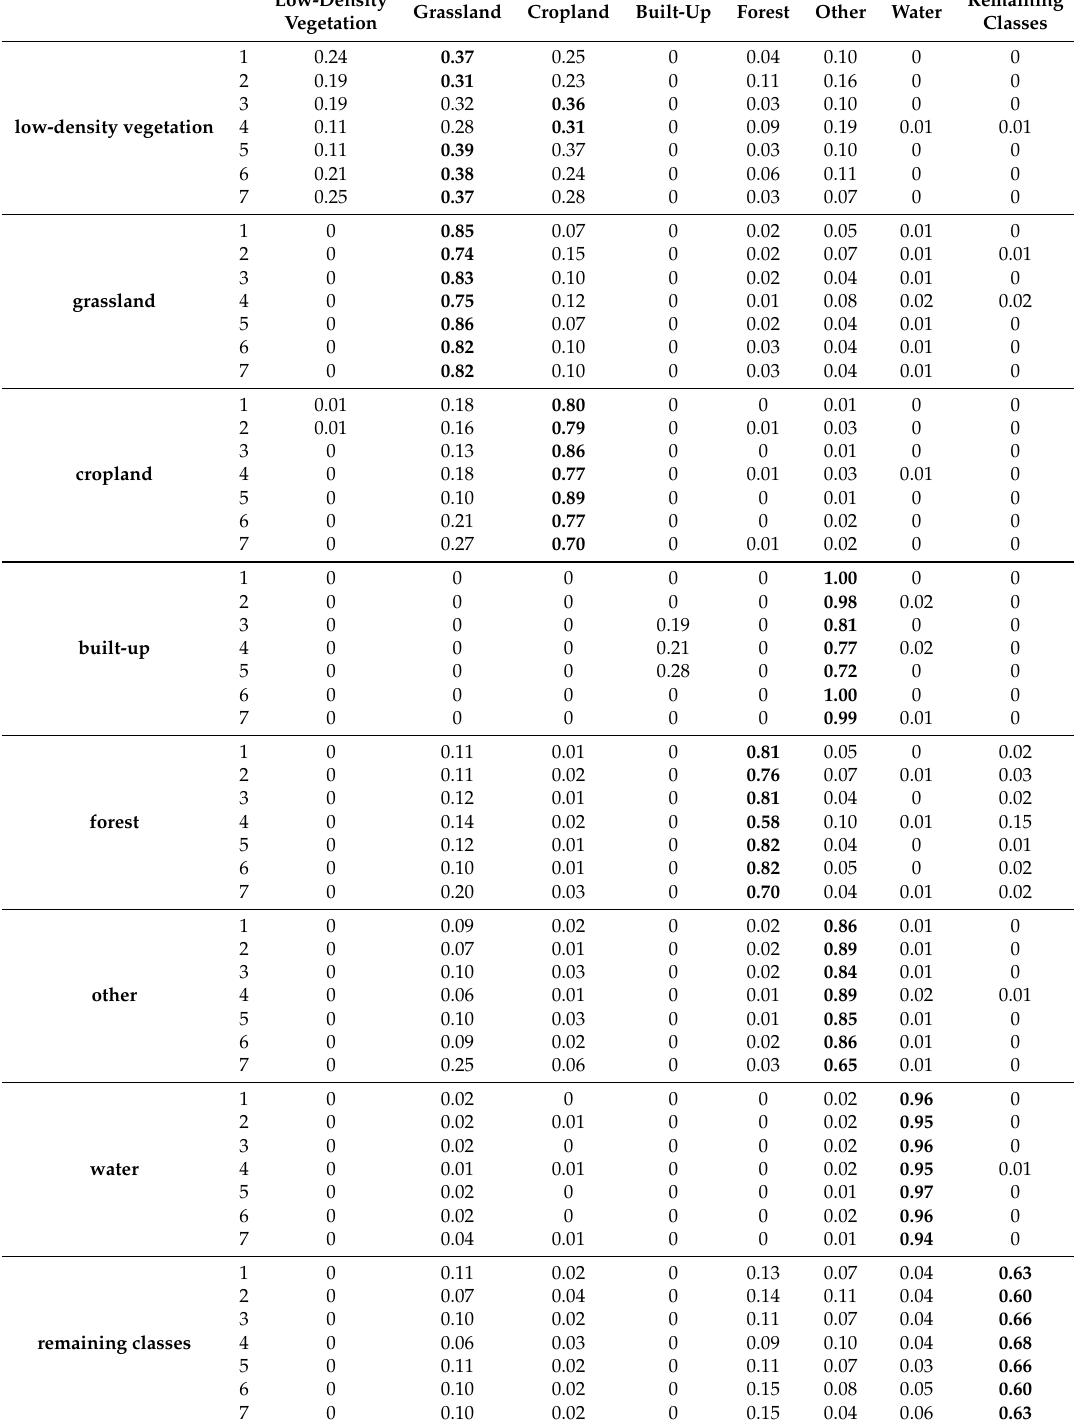
Table 4. Confusion matrix for selected